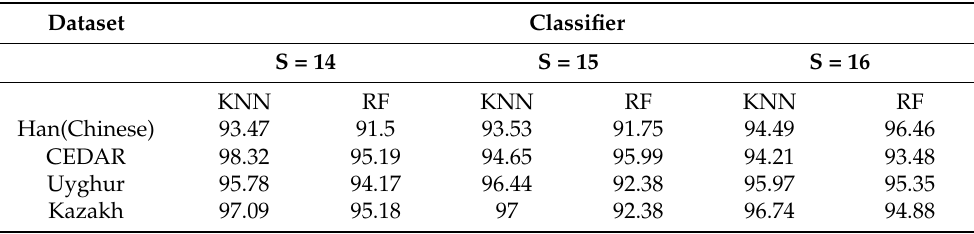
Table 3. Single language recognition results are based on HOG features.